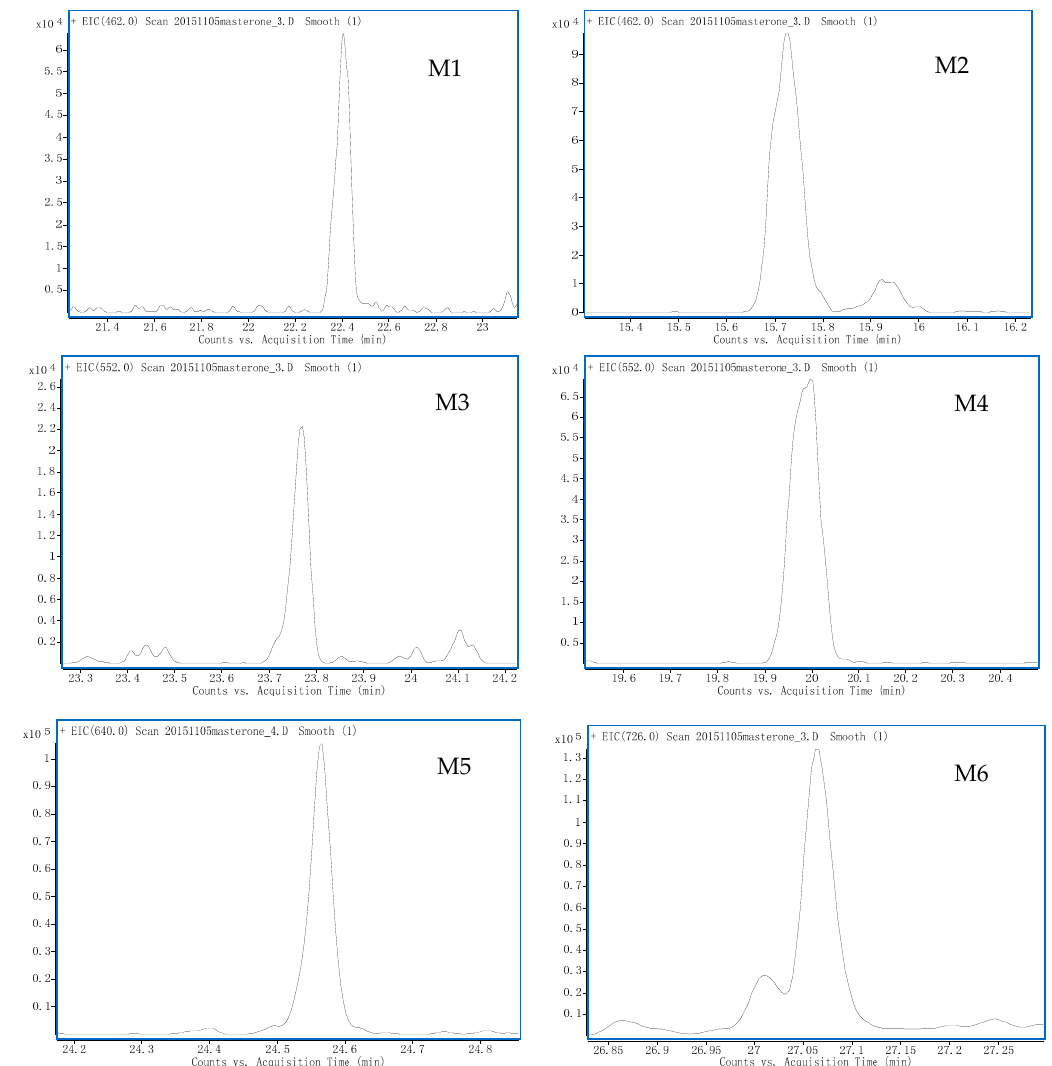
Figure 2. EIC chromatograms of 15 metabolites (EIC chromatograms of G1, G2, G3, G4, G5, G6, G7, S1 and S2 were required by LC-QTOF-MS in negative mode, while EIC chromatograms of M1, M2, M3, M4, M5 and M6 were required by GC-MS).